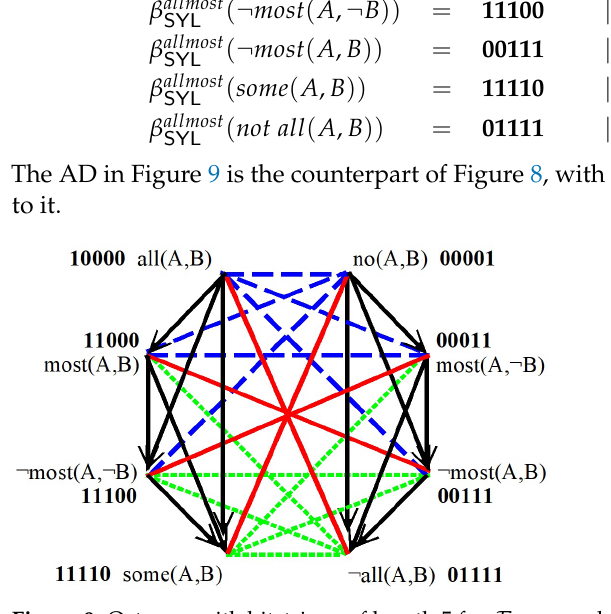
Figure 9. Octagon with bitstrings of length 5 for F allmost , relative to SYL